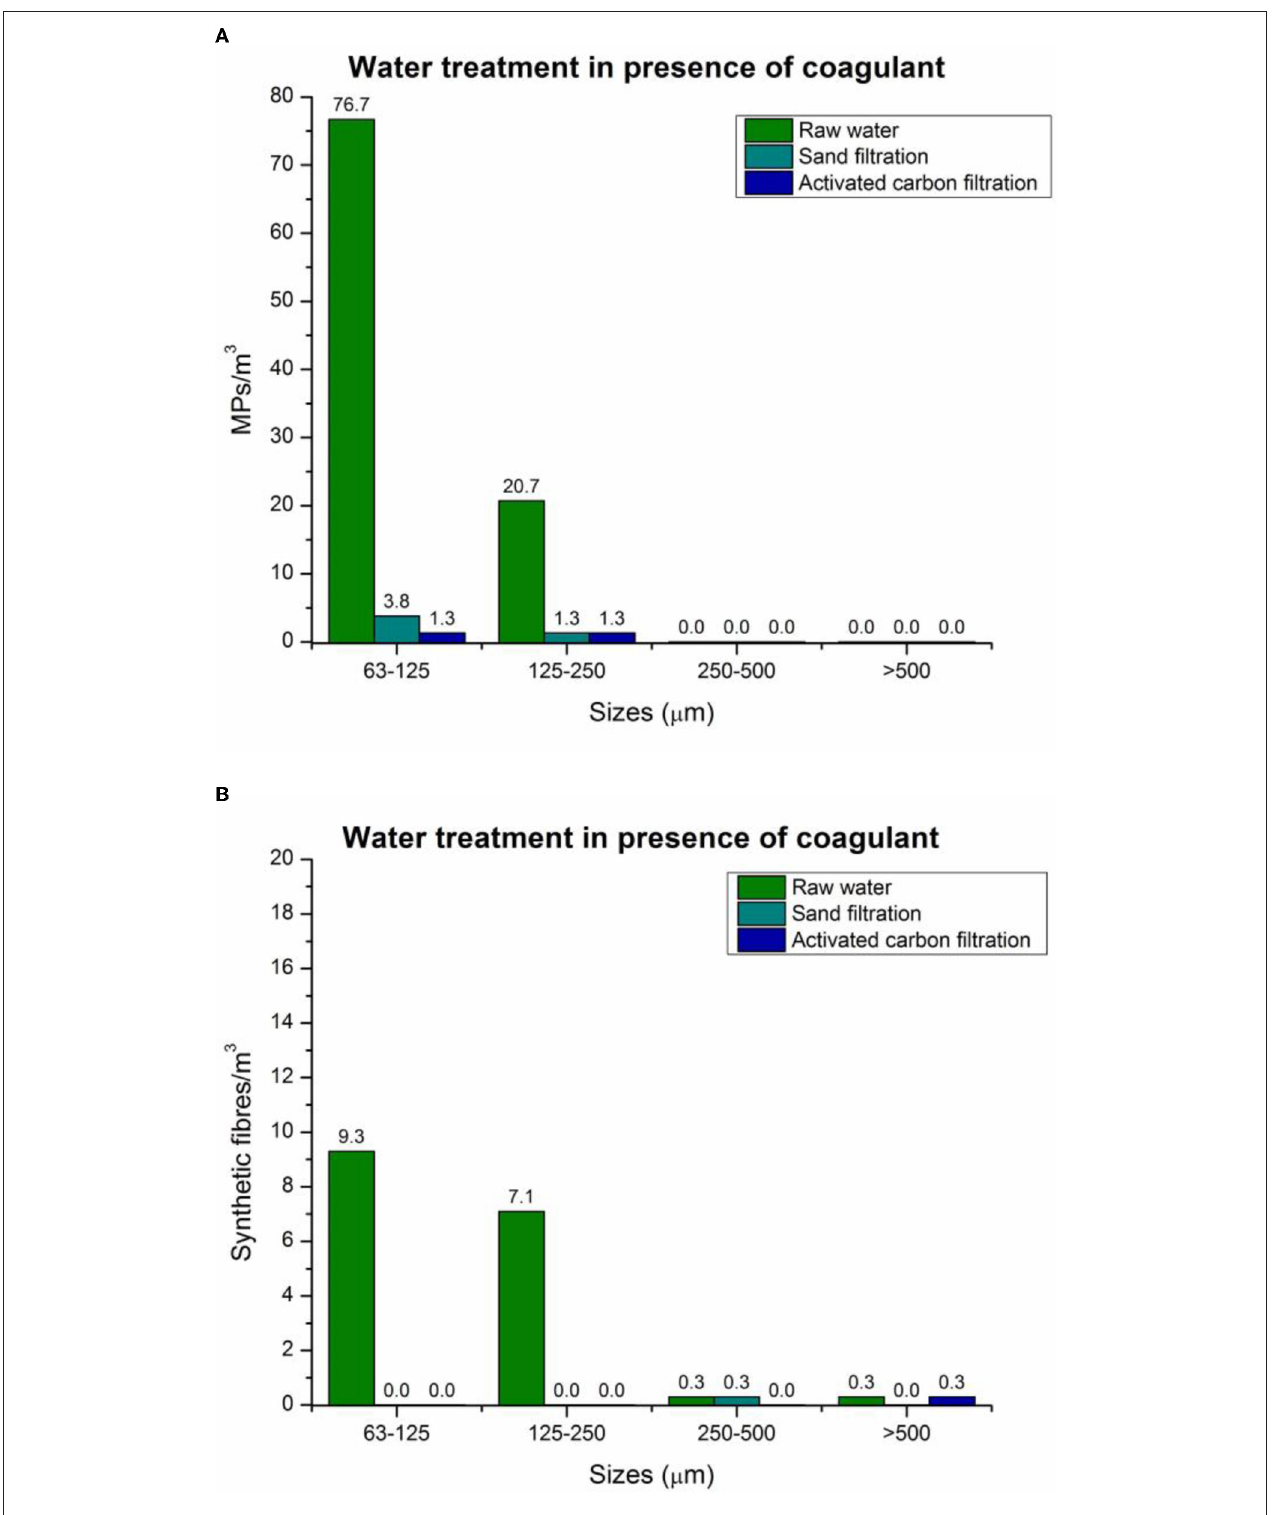
FIGURE 4 | Size distribution concentrations of MPs (A) and synthetic fibres (B) in presence of coagulant.